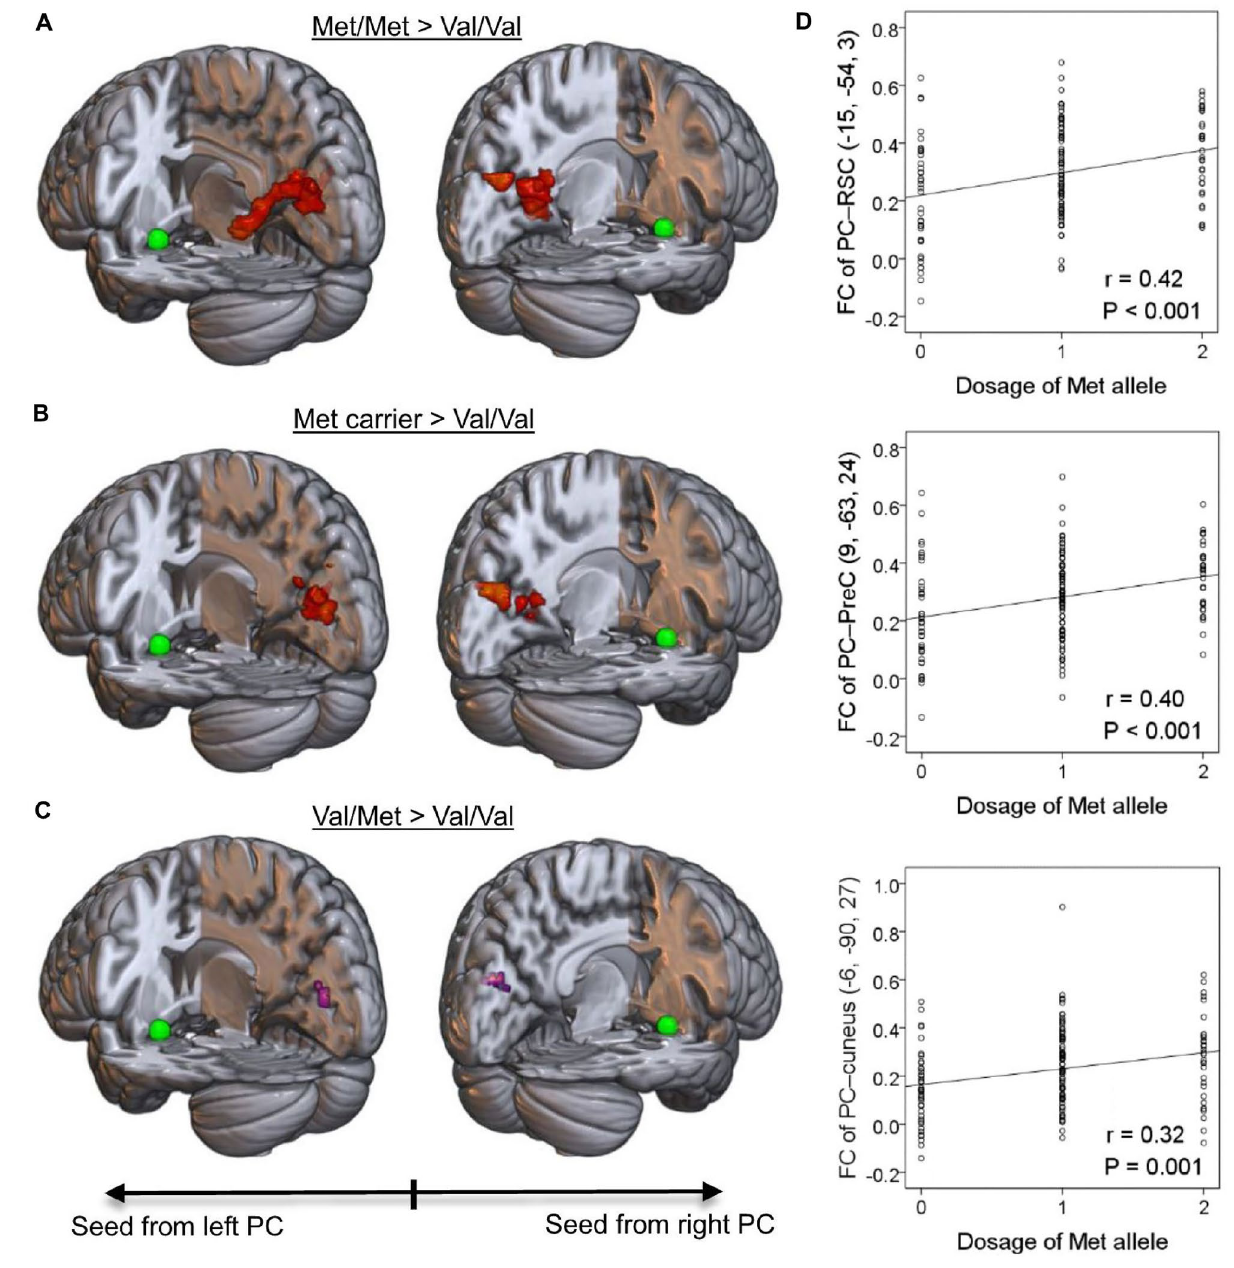
Figure 3. BDNF gene-informed piriform cortex (PC, in the green sphere)-seeded olfactory network (PDM cohort n = 145). ( A ) The between-group comparison of olfactory networks in the Met/Met and Val/Val groups exhibited hyper-connectivity to a confluent cluster including the retrosplenial cortex (RSC), posterior cingulate cortex (PCC), precuneus and cuneus ( P FWE-corr. < 0.001, in red). ( B ) The between-group comparison of olfactory networks among the Met carriers and Val/Val groups converged to the RSC and cuneus ( P FWE-corr. < 0.001). ( C ) The between-group comparison of olfactory networks in the Val/Met and Val/Val groups displayed sub- significant clusters in the cuneus ( P FWE-corr. = 0.471 and 0.464 as seeded from the left and right PC respectively, in violet). ( D ) Met-allele dosage effects were observed in all aforementioned PC-seeded neurodynamics. The peak coordinates and linear regression results for the Met-allele dosage effect can be found in Supplementary Table not be achieved under the conditions imposed by the COVID-19 pandemic. All subjects were right-handed, as confirmed using the Edinburgh Inventory 46 . All experiment procedures were conducted in accordance with the Declaration of Helsinki and were approved by the local ethics committee of Taipei Veterans General Hospital, and informed consent was provided by every participant.